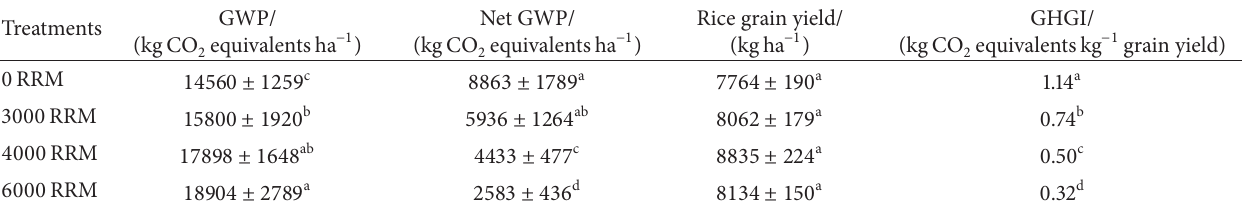
Table 3: GWP, net GWP, rice grain yield, and GHGI of different residue mulching treatments. Treatments